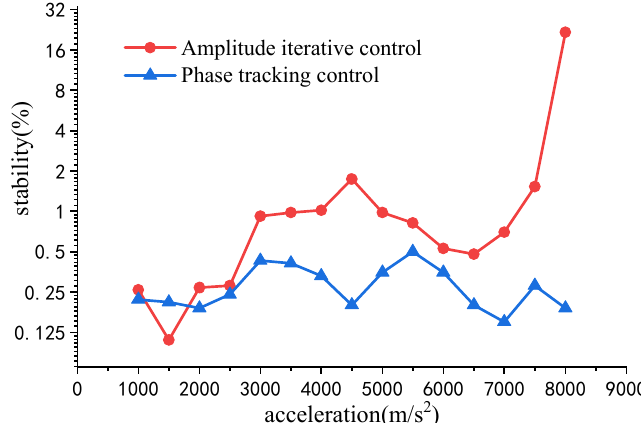
Figure 11. Amplitude stability comparison in the 1000–8000 m/s 2 stage.